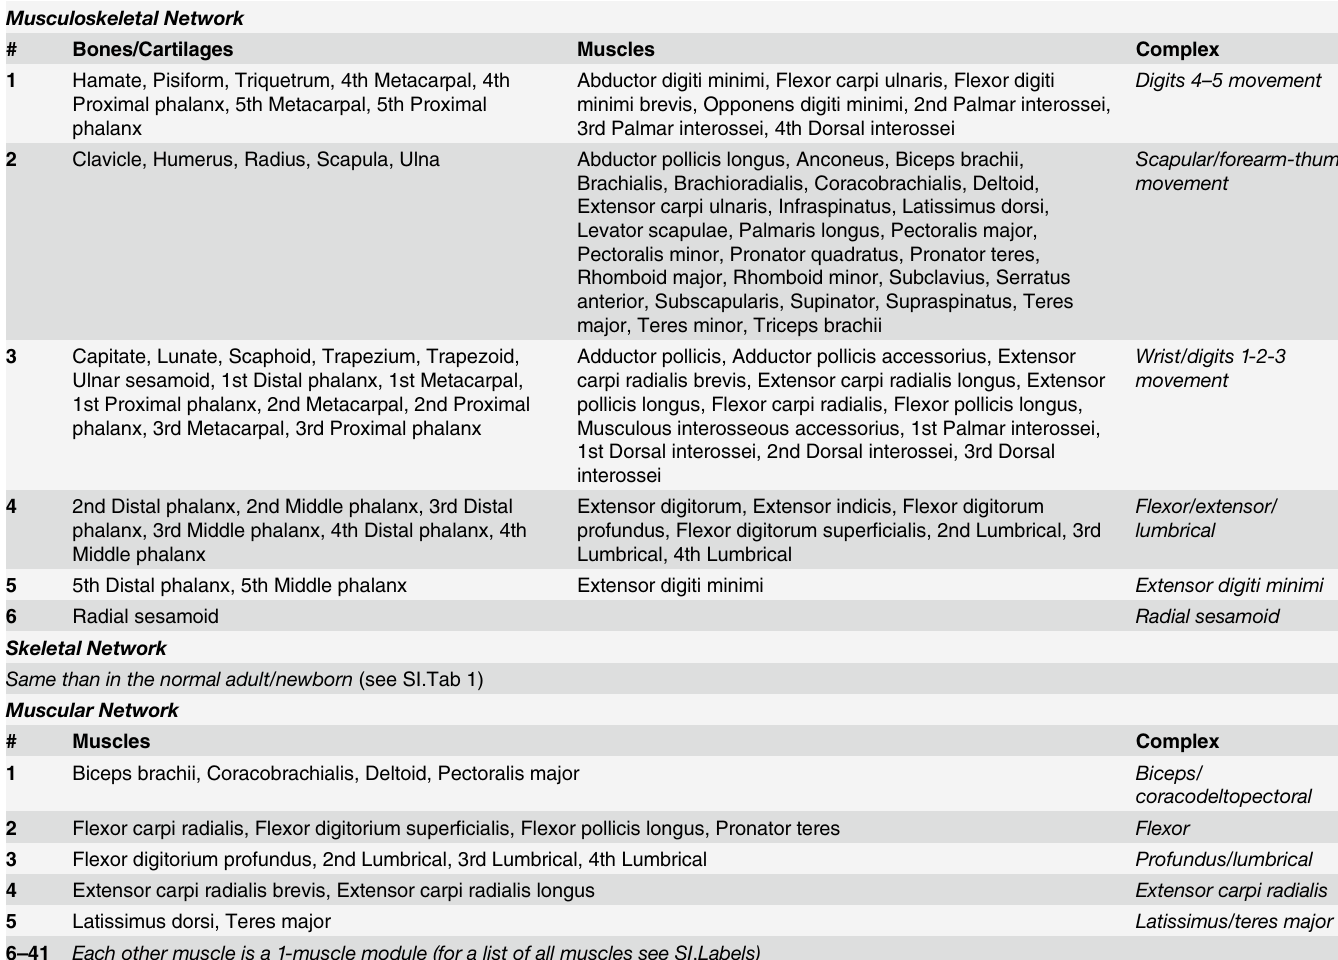
Table 6. Phenotypic modules of the T18 fetus right upper limb identified using